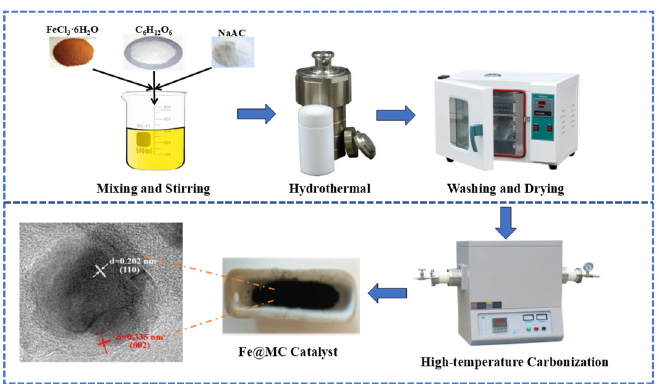
Figure 1. Catalyst preparation process.